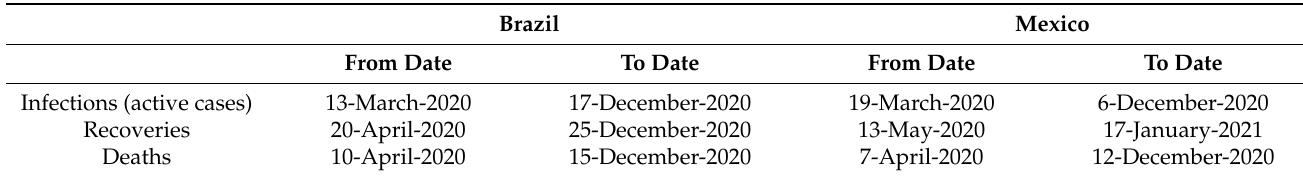
Table 1. Data durations for Brazil and Mexico